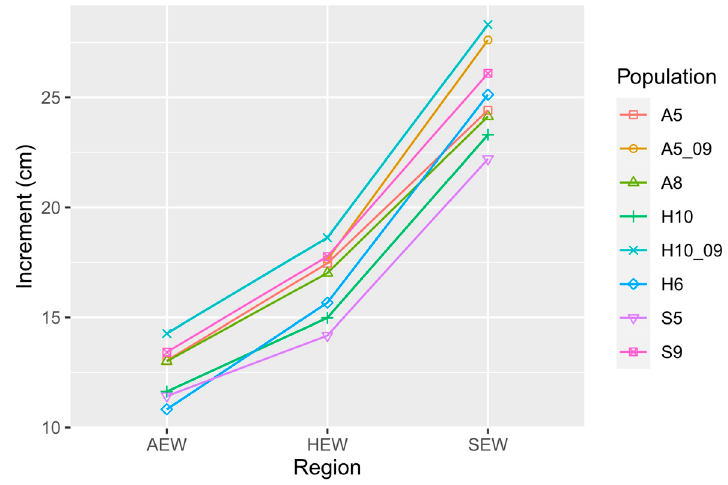
Figure 3. Interaction plot of mean plant height increment in 2015 of the di ff erent populations in the three study regions (please note that A5_09 was removed from AEW in the figure, since it is based on approx. half the sample size of the other populations and not significantly di ff erent to most populations (see Figure 4 for details), but would create the impression of superior plant height increment in the figure). (Populations from the SEW region: S5 and S9; from HEW: H10, H10_09, and H6; from AEW: A5, A5_09, and A8. For the populations H10 and A5, seeds from 2009 were also available for raising seedlings and are named H10_09 and A5_09, respectively).